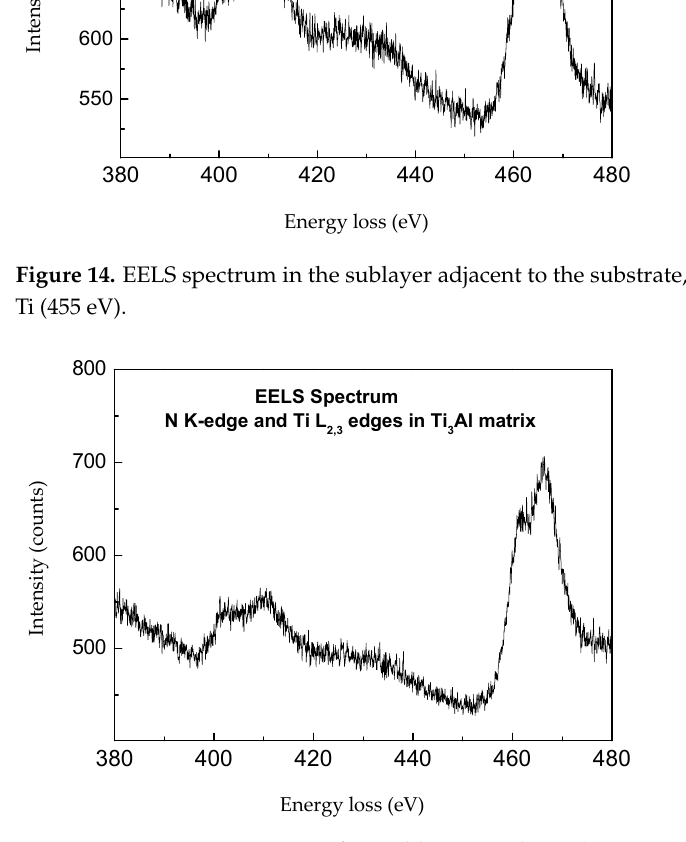
Figure 15. EELS spectrum in surface sublayer, K Edge N (399 eV) and L edge Ti (455 eV). Table 6. Ti/N element content ratio, results reported in at. %.